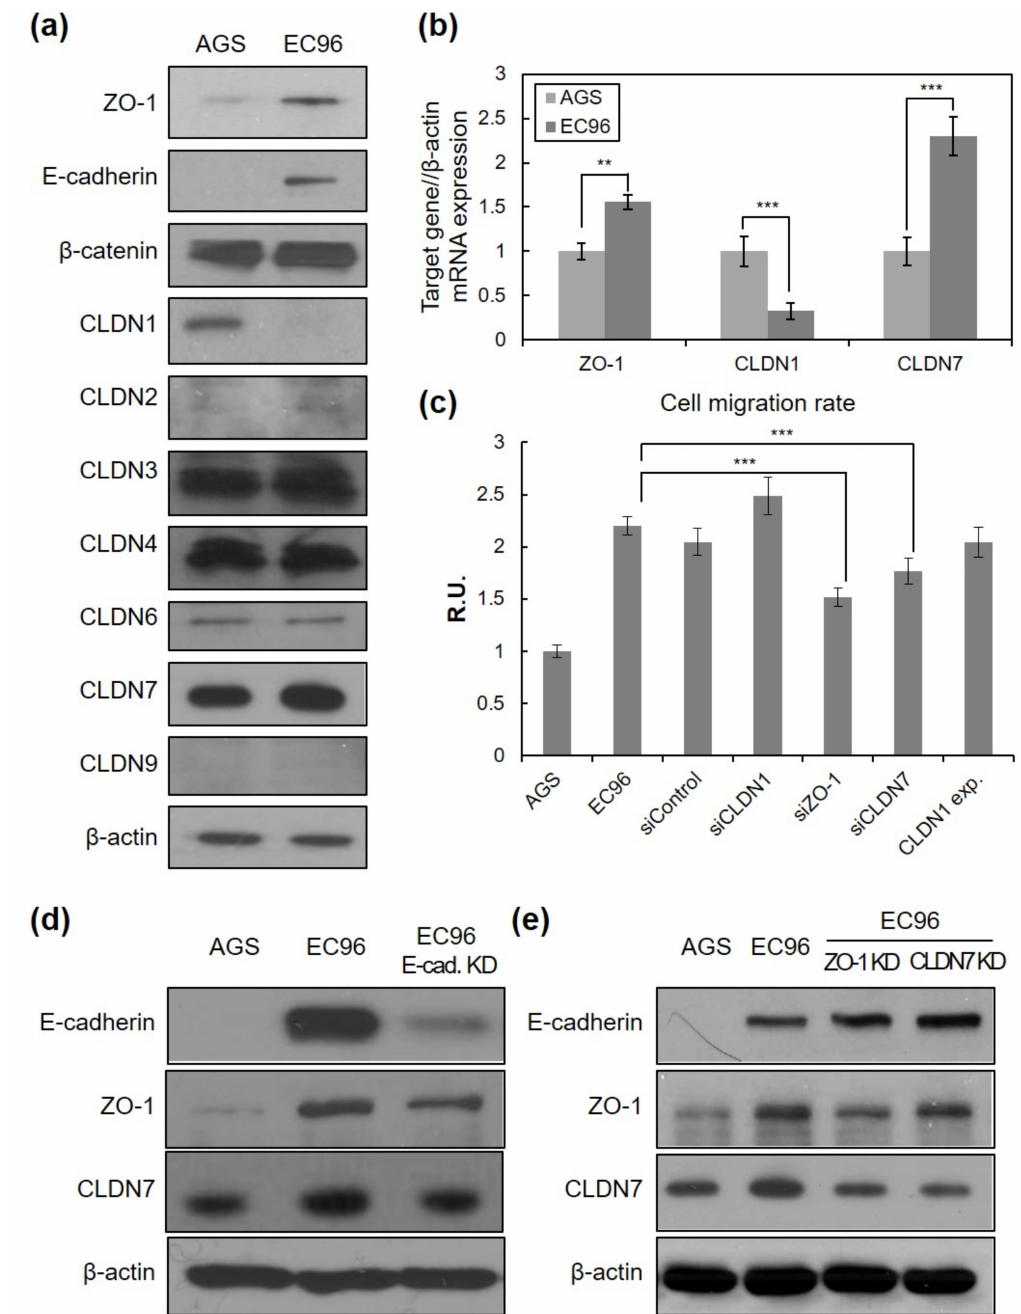
Figure 3. Tight junction proteins are related to cell migration. ( a ) Cell lysates were subjected to immunoblot analysis for ZO-1, E-cadherin, β -catenin, CLND-1, -2, -3, -4, -6, -7, -9, and β -actin. ( b ) Total RNA extracted from AGS and EC96 gastric cancer cells were subjected to RT-PCR with ZO-1, CLDN1, and CLDN7-specific primers. Averages of three independent experiments with error bars are presented. ** p < 0.01; *** p < 0.001. ( c ) EC96 cells were transfected with 100 nM of ZO-1, CLDN1, CLDN7 siRNA (“siZO-1, siCLDN1, siCLDN7) or scramble control siRNA (“siControl”) or 1 µ g of the CLDN1 expression vector. In vitro cell migration was tested by the wound healing assay. Averages of five independent experiments with error bars are presented. *** p < 0.001. ( d ) AGS, EC96, and E-cad. KD (E-cadherin-knockdown EC96) cell lysates were subjected to immunoblot analysis for E-cadherin, ZO-1, CLDN7, and β -actin. ( e ) AGS, EC96, ZO-1 KD (ZO-1-knockdown EC96), and CLDN7 KD (CLDN7-knockdown EC96) cell lysates were subjected to immunoblot analysis for E-cadherin, ZO-1, CLDN7, and β